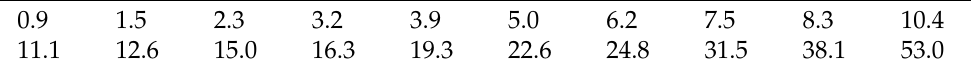
Table 6. The dataset contains the first failure time (in months) of electric trolleys within large manufacturing plants for transportation and delivery.